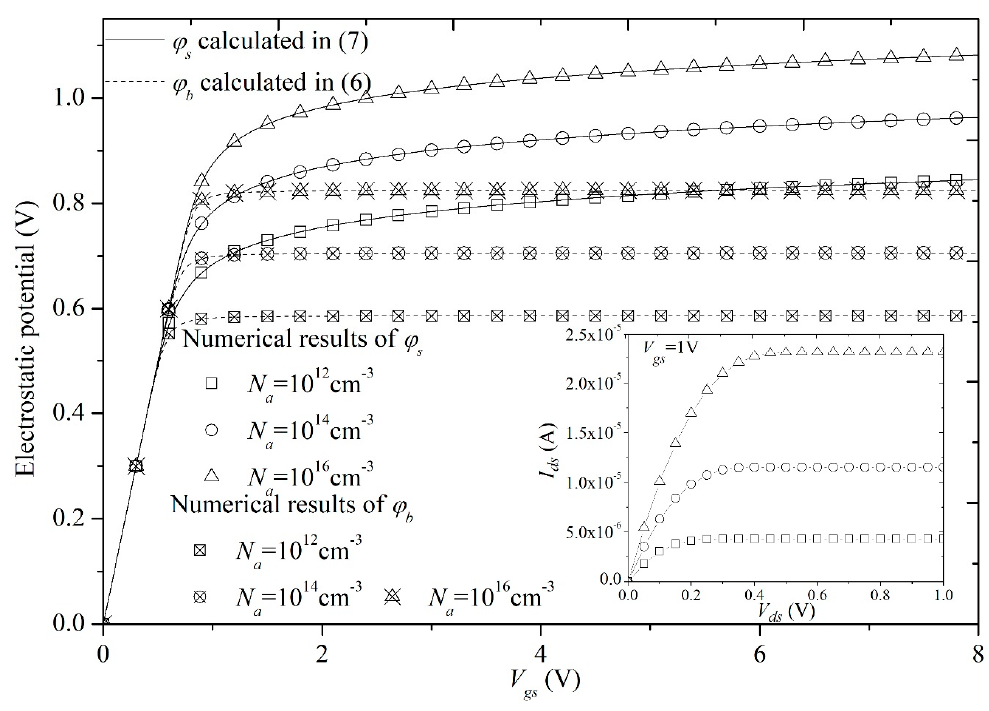
Figure 6. Comparisons between the surface potential calculation scheme and numerical results for di ff erent N a , and the drain current in